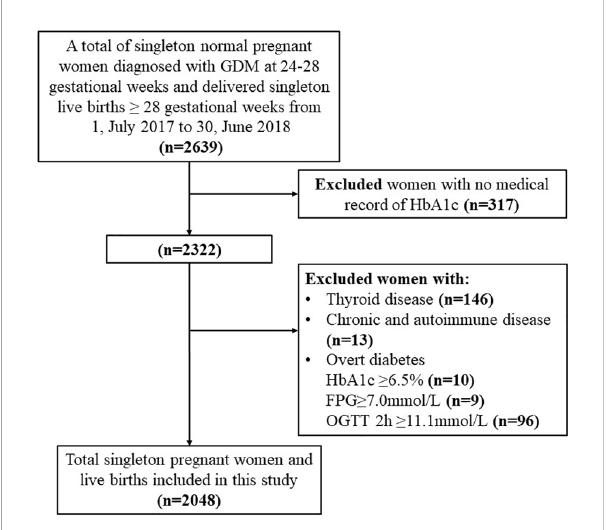
FIGURE 1 Flow chart of the study population. Demonstrates the inclusion and exclusion criteria of our study population; glycated hemoglobin A1c (HbA1c); gestational diabetes mellitus (GDM); fasting plasma glucose (FPG); 2hPG (2-hour plasma glucose); Oral glucose tolerance test (OGTT); chronic diseases (hypertension, liver, kidney, heart, lung